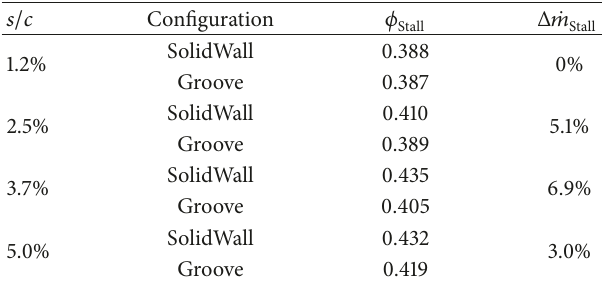
Table 2: Stalling flow coefficients and percentage reduction of stall mass flow for each